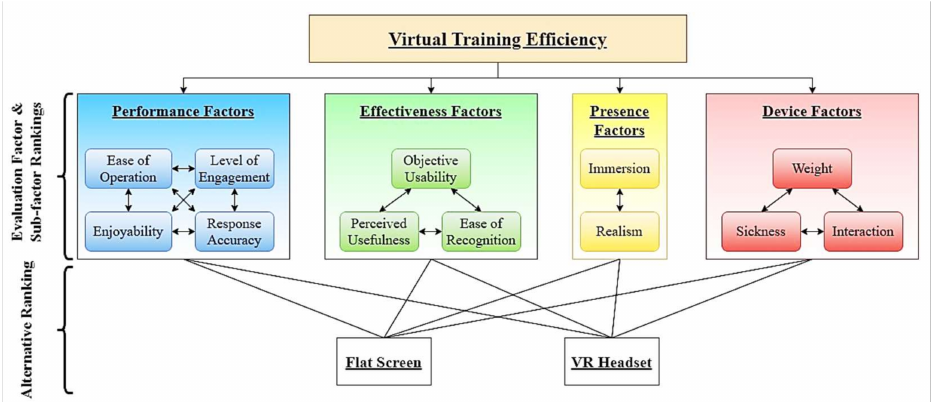
Figure 4. IT2F-AHP analysis of criteria for evaluation of training